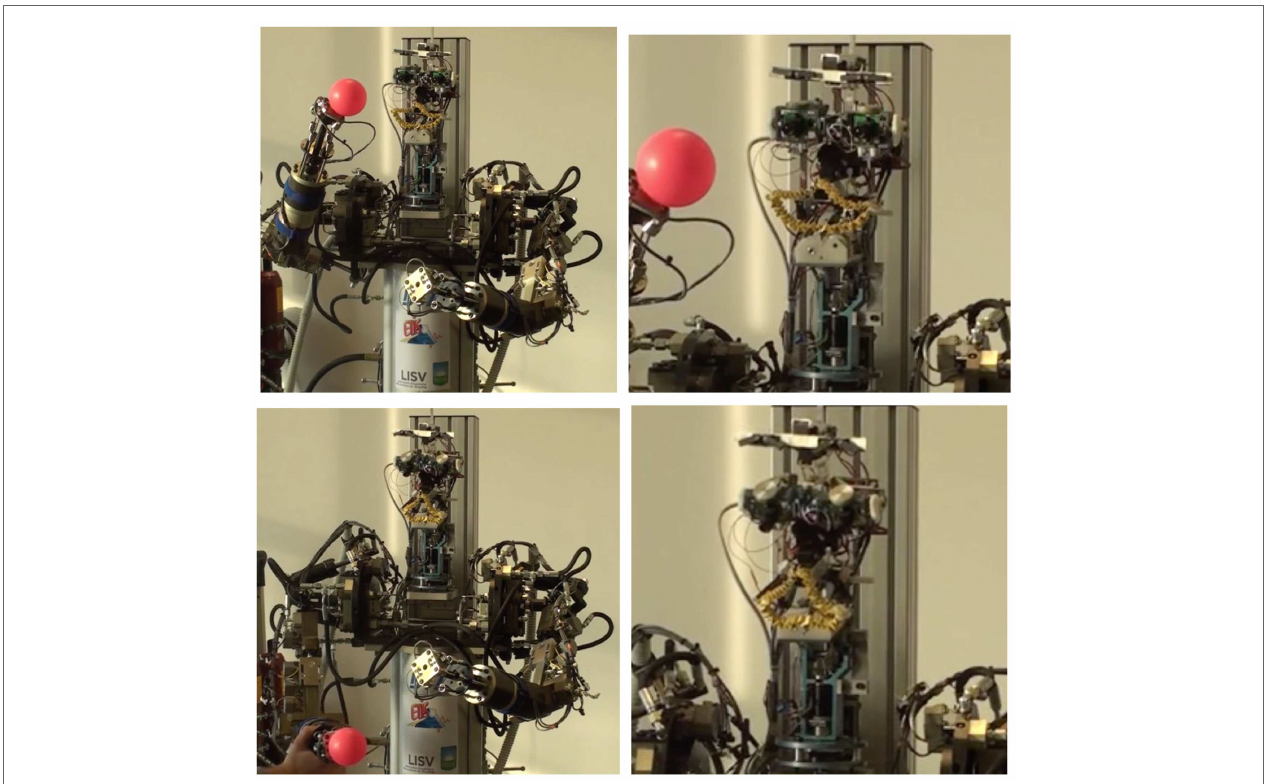
FIGURE 16 | HYDROïD robot head showing basic emotions function of seeing the ball: happy (up left) with zooming on up right and angry (down left) with zooming on down right .